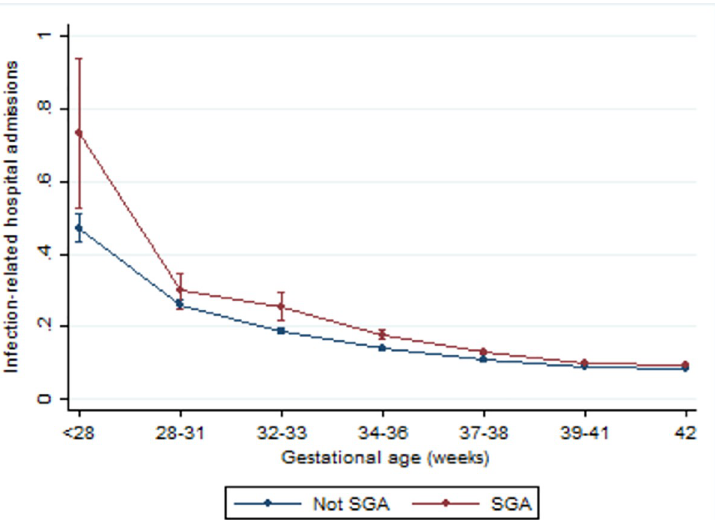
Fig 3. Estimated mean number of infection-related hospital admissions per child by gestational age at birth and small for gestational age (SGA), adjusted for: Maternal age at birth; marital status; Index of Multiple